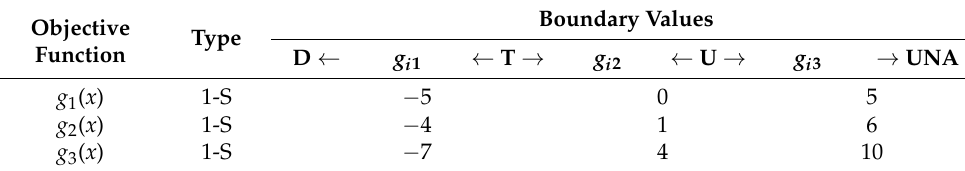
Table 6. Boundary values of